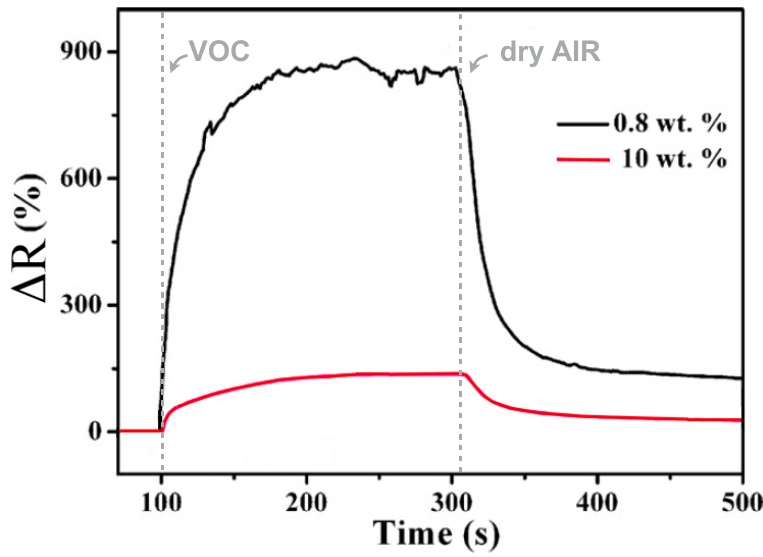
Figure 23. Relative resistance variations of CNT/TPU composites with different CNT contents upon exposure with 7.0 vol% of chloroform vapours. Adapted from Zhu et al. [158]. The vapour responses were found to be coherent with the CNT content, vapour concentration